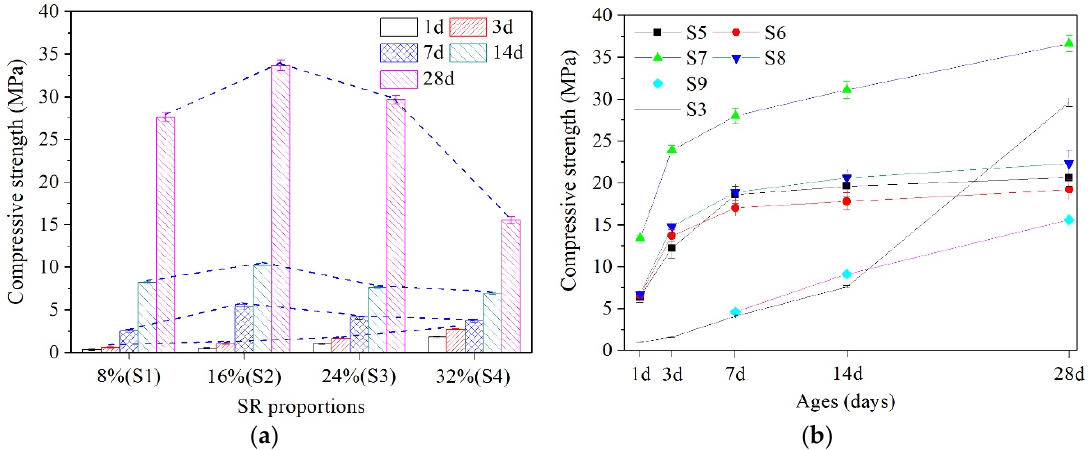
Figure 5. Compressive strength of AAS pastes: ( a ) S1–S4; ( b ) S3,